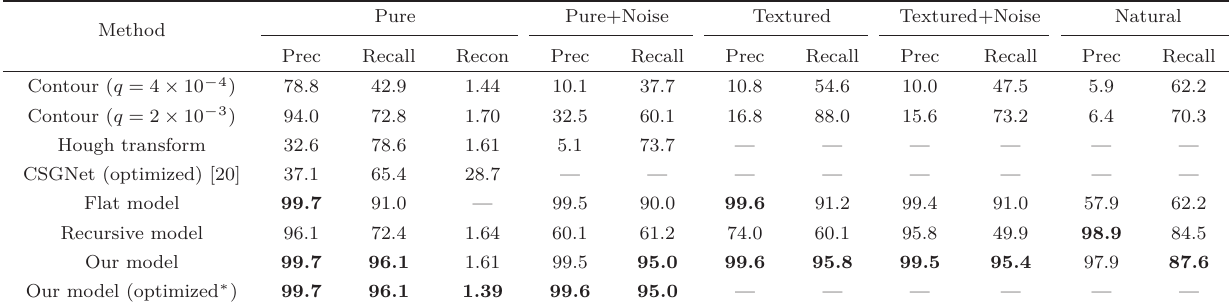
using the layered prediction